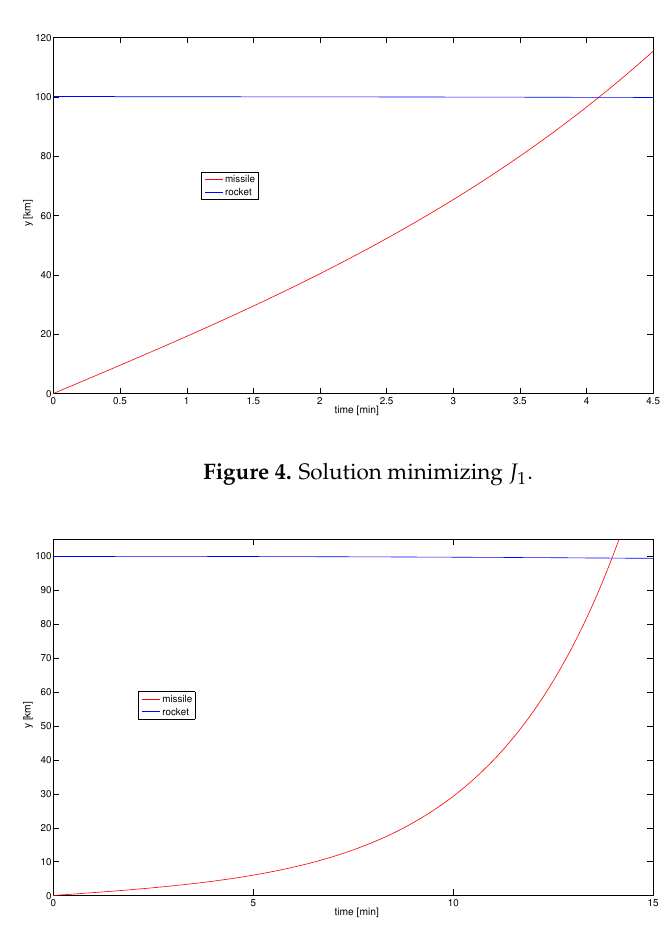
Figure 5. Solution minimizing J 2